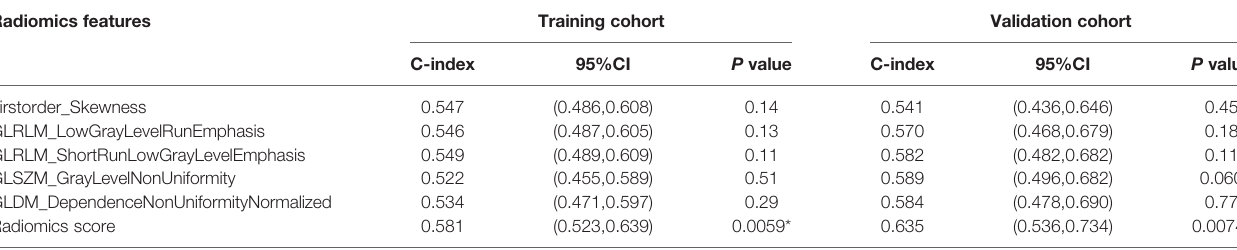
TABLE 2 | The performance of the selected radiomics features and constructed radiomics signatures.